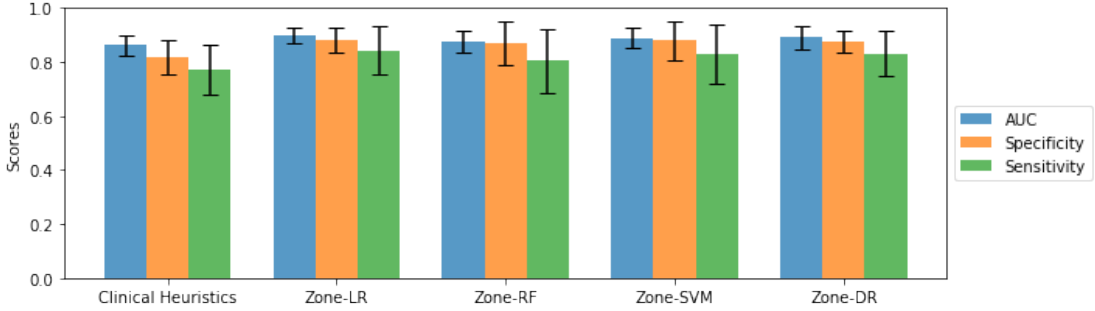
Figure 6. Performance bar plot (with error bars) zone-level, pathologically-verified prostate cancer grading results for the tested zone-level prostate cancer sensing strategies using CHB-DWI, averaged over 5 folds, along with their corresponding standard deviation.